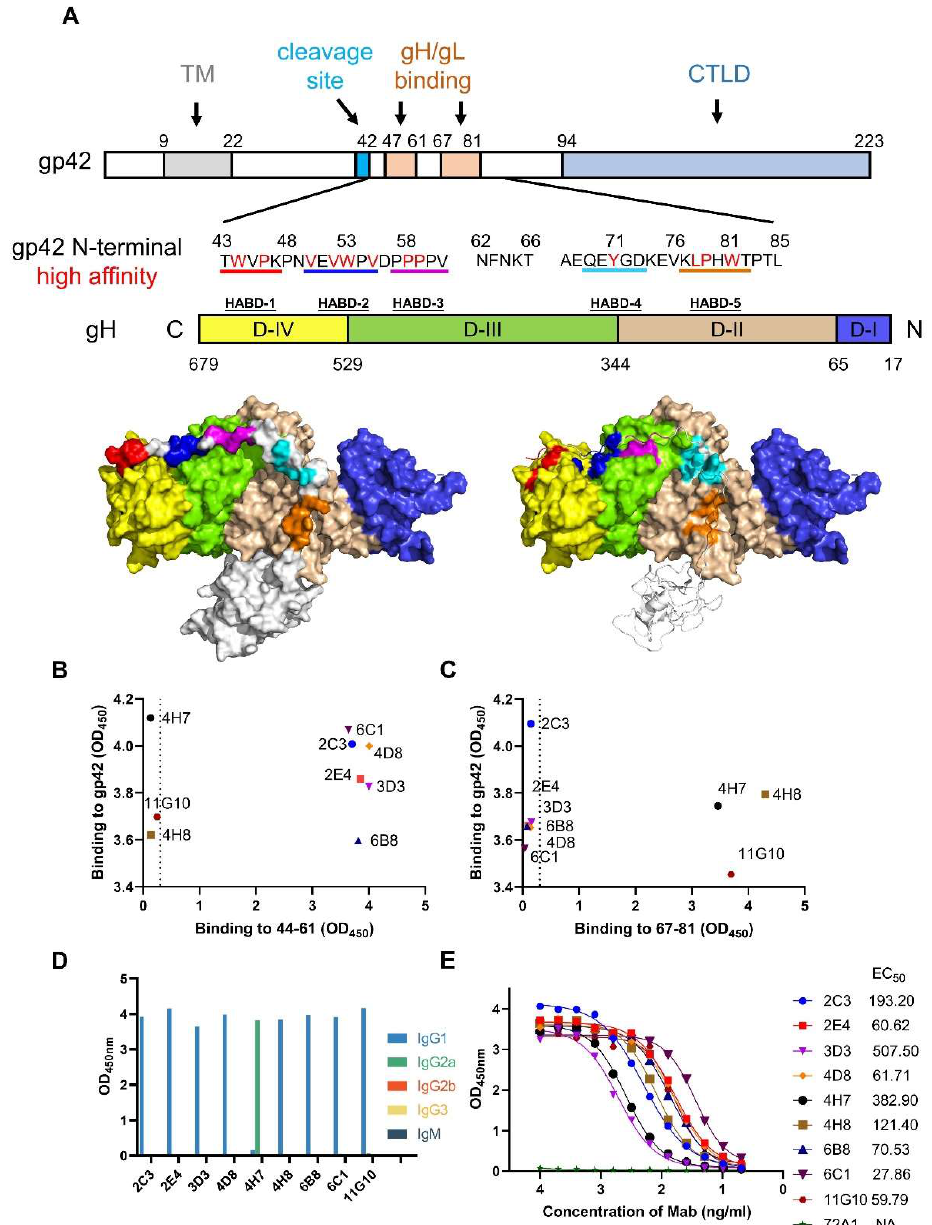
Figure 1. Generation of gp42 N-terminal region-specific mAbs. ( A ) Graphical representation of gp42 and gH/gL protein. The major functional domains of gp42 are indicated by labeling with different colors. Transmembrane domain (TM) in gray, cleavage site in cycan, gH/gL binding site in light orange and C-terminal lectin domain (CTLD) in light blue. The amino acids of gp42 N-terminal region are listed and residues interacting with gH are colored in red. gH domains (D-IV to D-I) are colored in yellow, green, light brown and blue, respectively. Structure models of gH/gL/gp42 show the high-affinity binding determinants (HABDs) of gH and corresponding interacting regions on gp42, which are colored in red, blue, magenta and orange, respectively. Structure models were drawn with PyMOL and the PDB accession number of gH/gL/gp42 is 5T1D. ( B , C ) The binding ability of hybridomas to gp42 protein and ( B ) gp42-44-61aa peptide or ( C ) gp42-67-81aa peptide were assessed using ELISA assay. ( D ) Identification of antibody subtypes. ( E ) Binding activities of antibodies were tested and the EC 50 values were calculated.